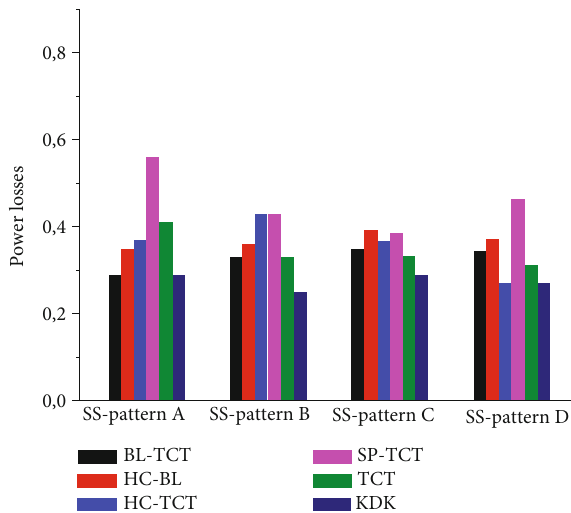
Figure 15: Power losses of the di ff erent topologies under homogeneous shading conditions.